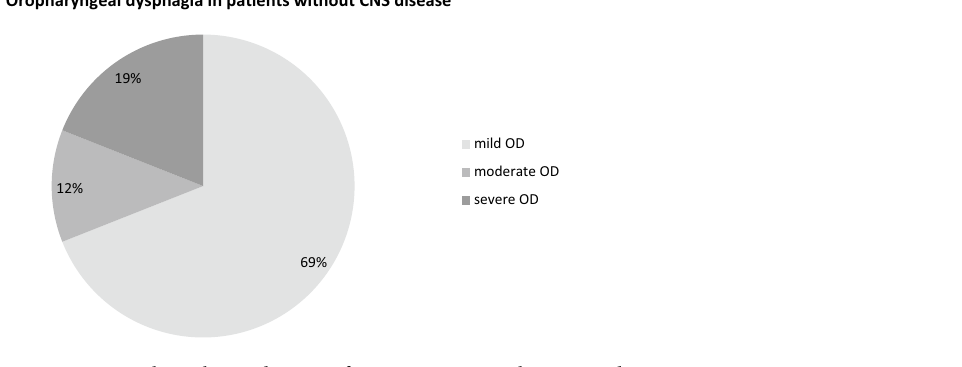
Figure 3. Prevalence by graduation of OD in patients without CNS